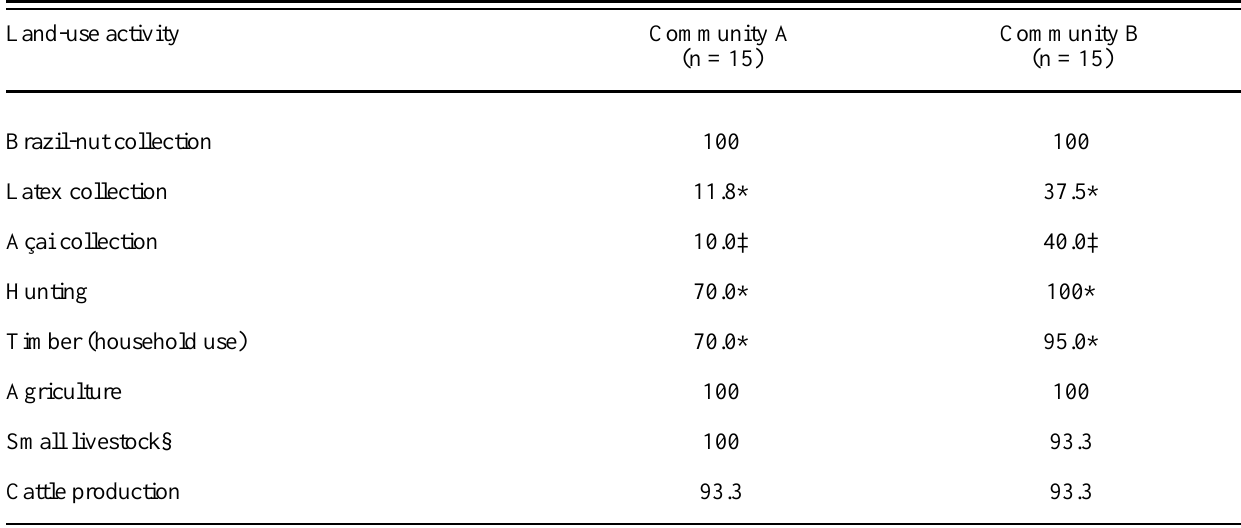
Table 2. Percentage of households in each community participating in specific land-use